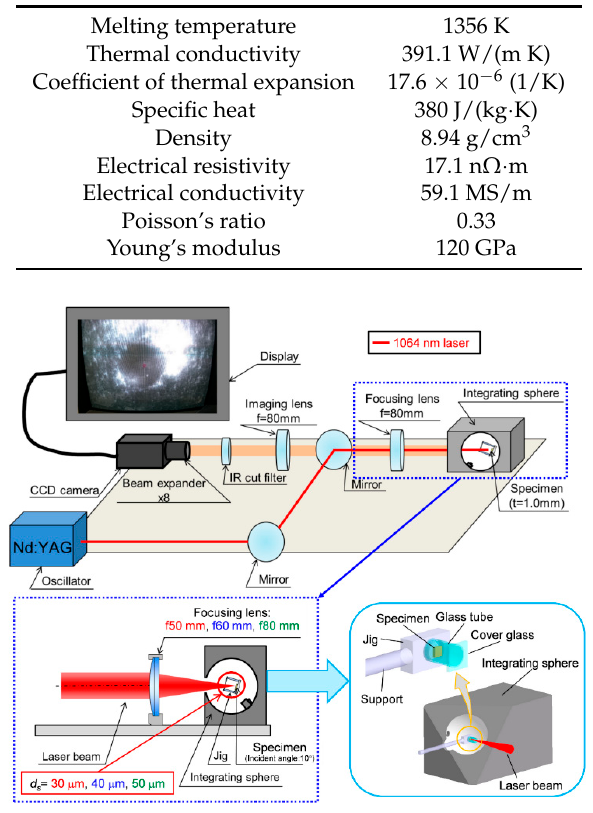
Figure 2. Schematic illustration of experimental setup for measurement of absorption rate.